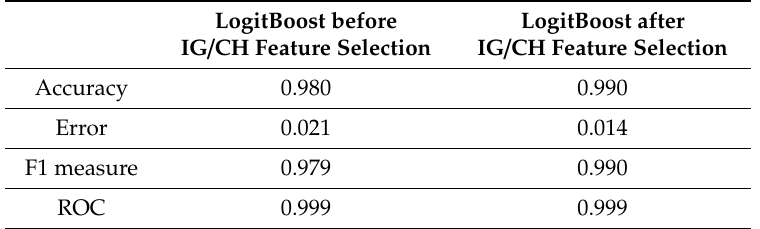
Table 8. Performance of LogitBoost classification before and after information-gain attribute evaluation / Chi-square attribute evaluation (IG / CH) feature